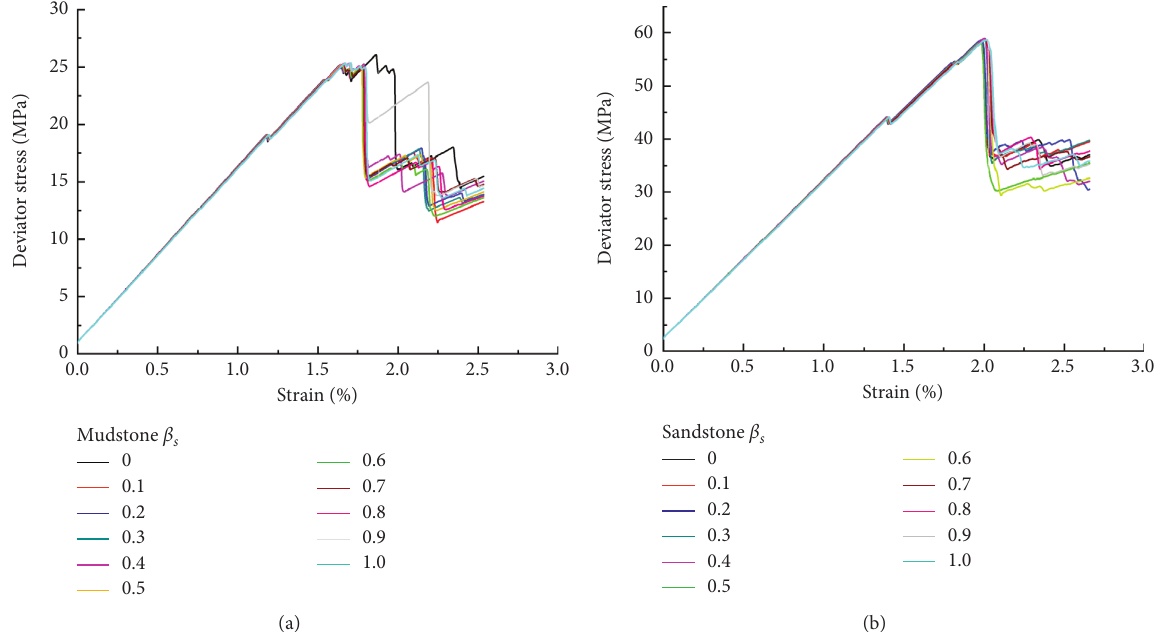
Figure 12: Mudstone (a) and sandstone (b) stress-strain curves under different β